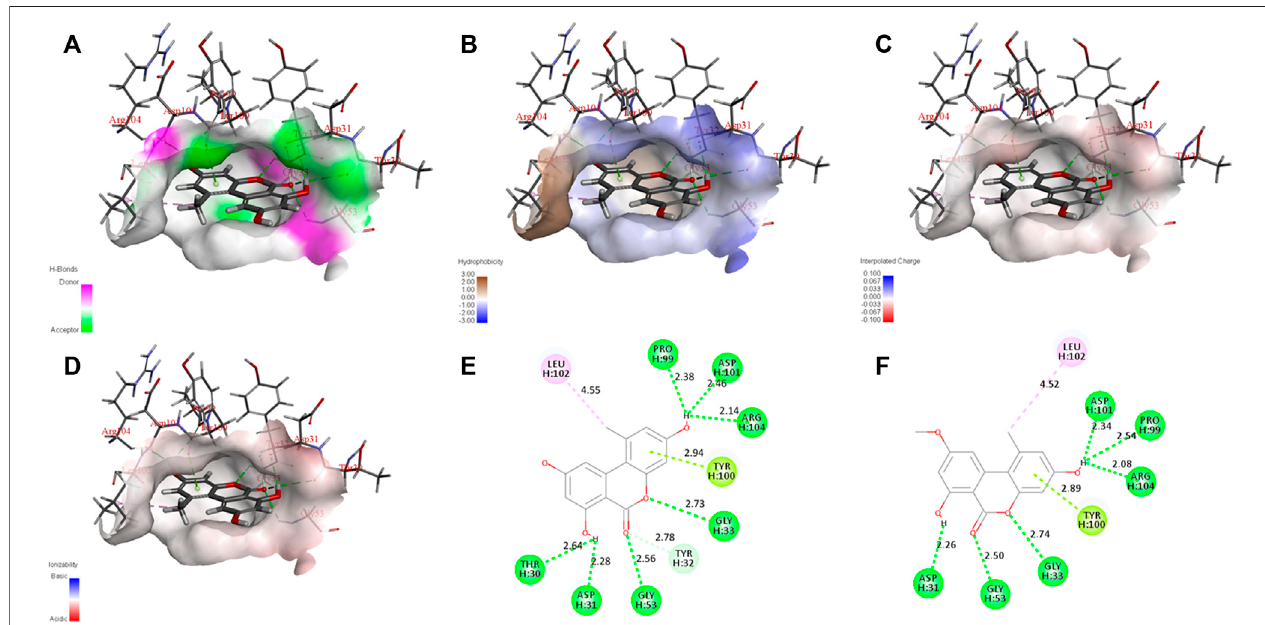
FIGURE 5 | Interaction between AOH/AME and scFv. (A) Hydrogen bond donors and acceptors around the binding cavity (green represents the receptor and purplerepresentsthedonor.) (B) Hydrophobicityaroundthebindingcavity(bluerepresentshydrophilicityandbrownrepresentshydrophobicity). (C) Chargearoundthe binding cavity (blue represents positive electricity and red represents negative electricity). (D) The acid – base around the binding cavity (blue represents basic and red represents acidic). (E) Two-dimensional diagram of interactions between scFv and AOH. (F) Two-dimensional diagram of interactions between scFv and AME (green represents hydrogen bond interaction, cyan represents π -lone pair interaction, and pink represents alkyl interaction).